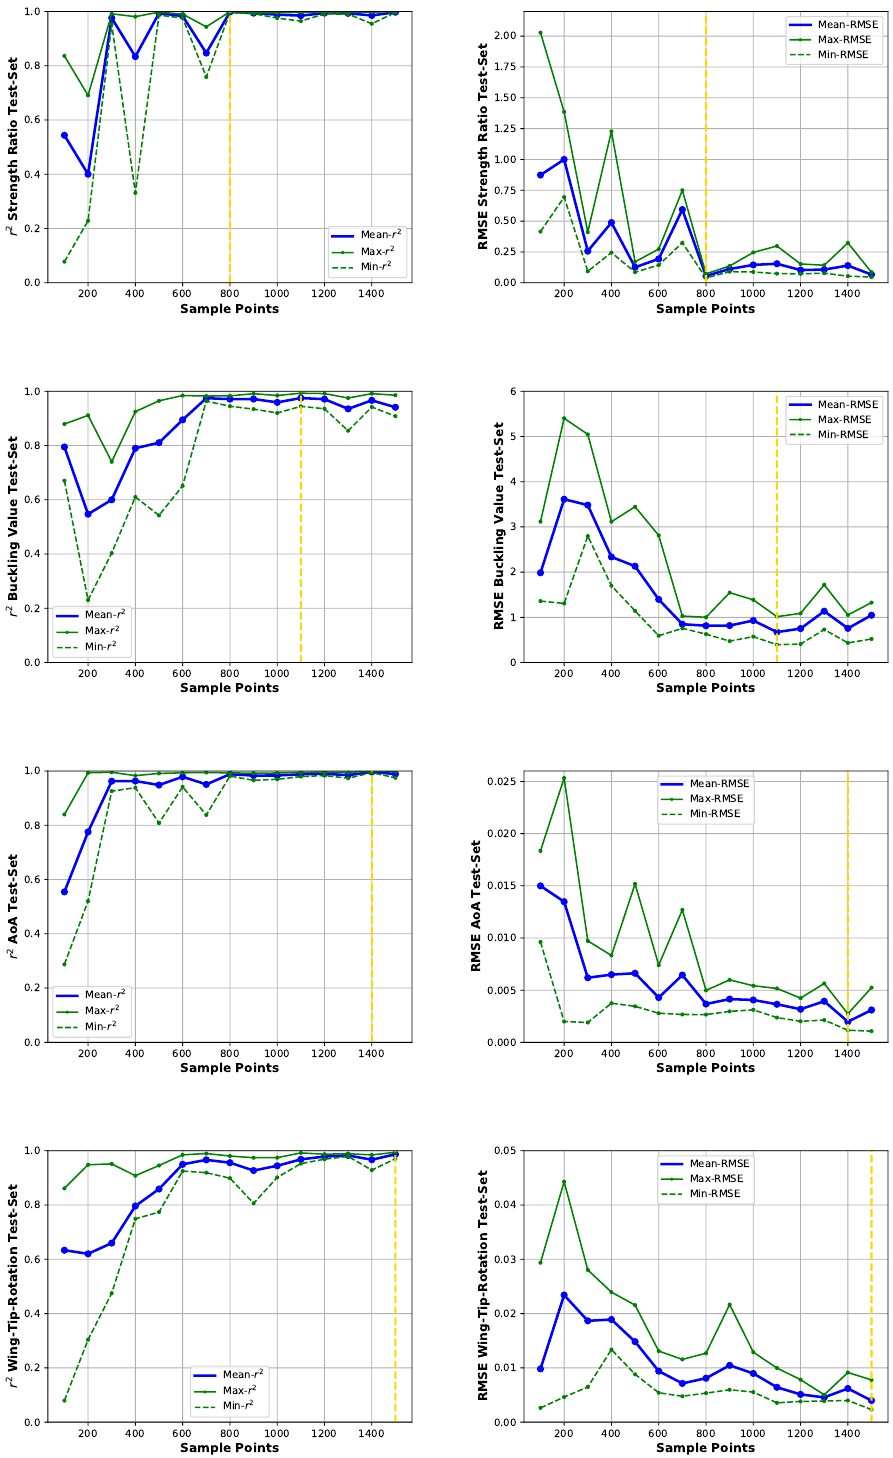
Figure 7. Cross-validation results for the constraints strength-ratio, buckling eigenvalue, AoA and